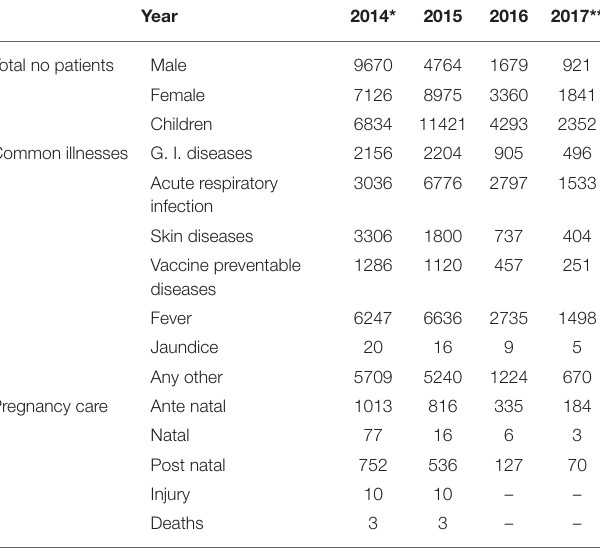
TABLE 6 | Health status IDPs in Dera Ismail Khan.